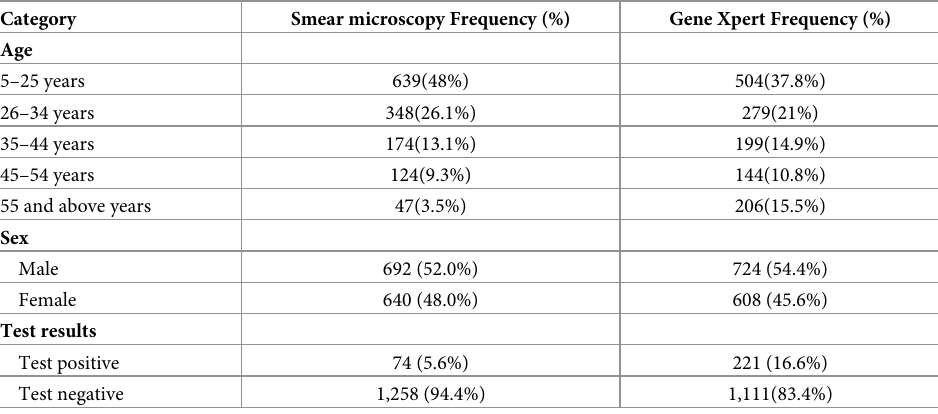
Table 1. Characteristics of TB suspected patients by testing technique.